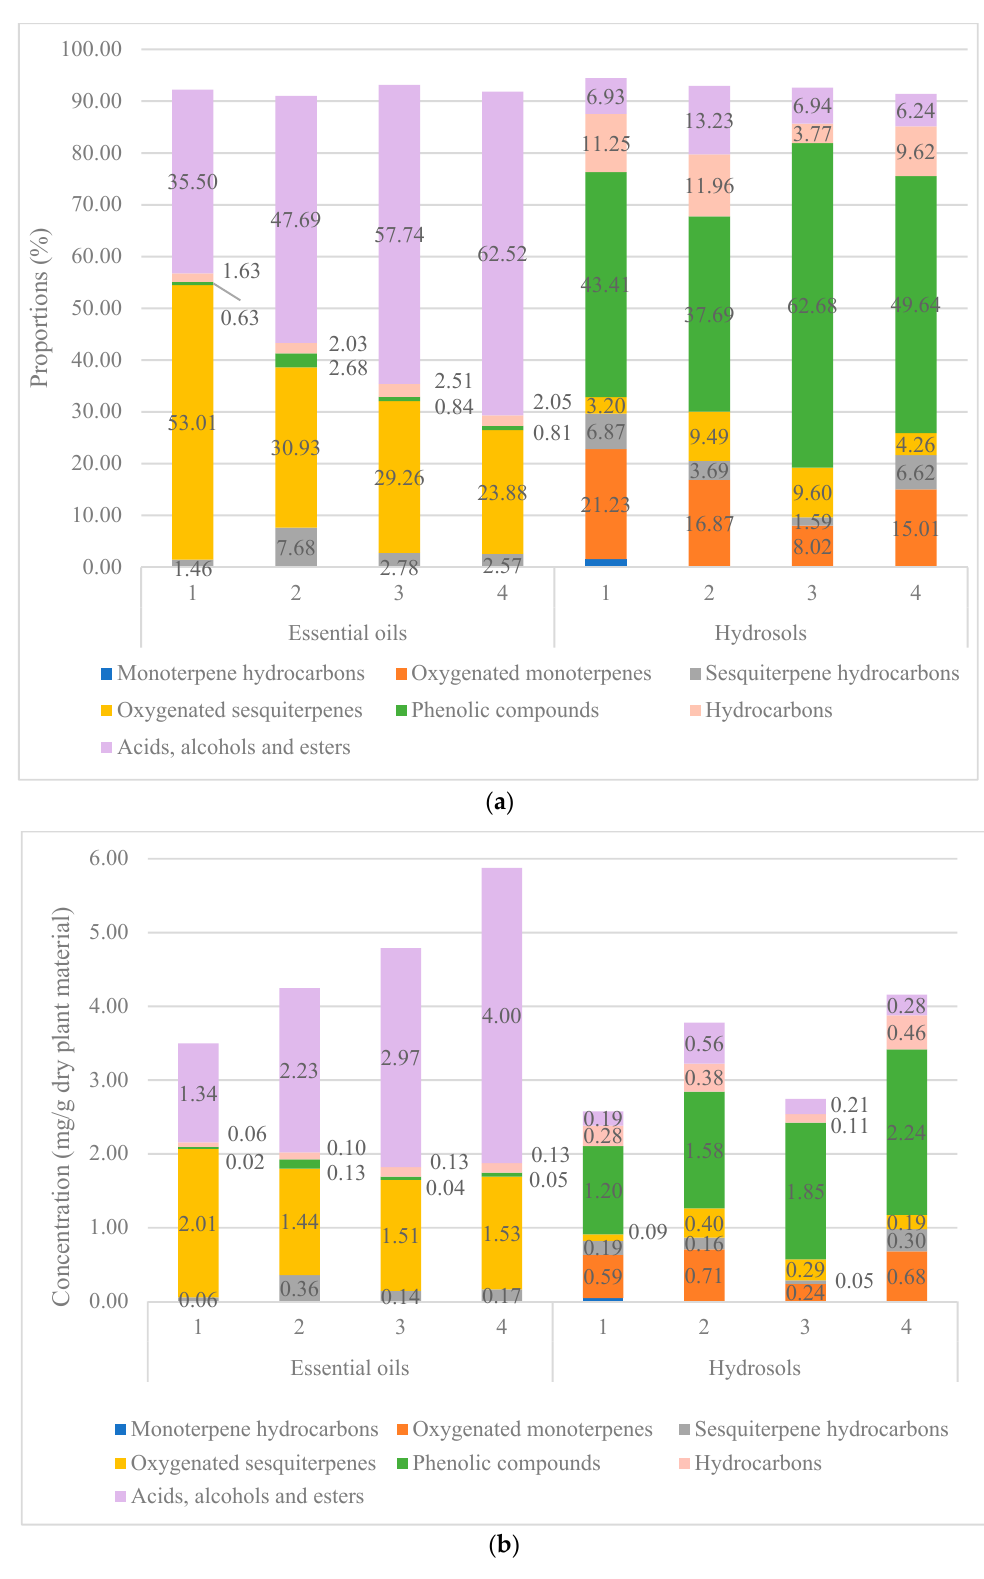
Figure 2. Volatile compounds distribution by categories for all samples of essential oils and hydrosols from four locations; ( a ) based on the relative peak area identification (data from Tables 1 and 2); ( b ) based on the concentration of volatile components in dry plant material (data from Tables S1 and S2).